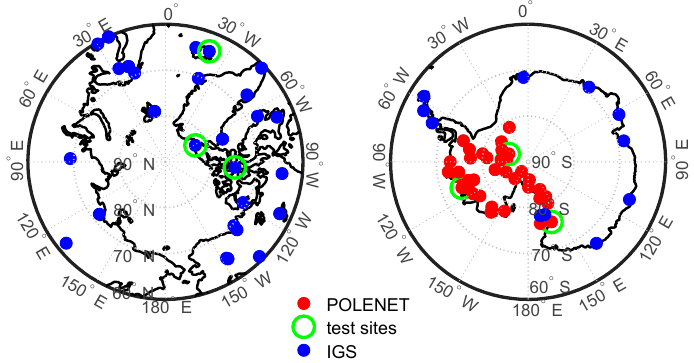
Figure 1. The geographical locations of global positioning system (GPS) tracking stations, including the International GNSS (global navigation satellite system) Service (IGS) stations (blue dots), the Polar Earth Observing Network (POLENET) stations (red dots), and the verification stations (green circles) in the Arctic ( left ) and Antarctic ( right ).